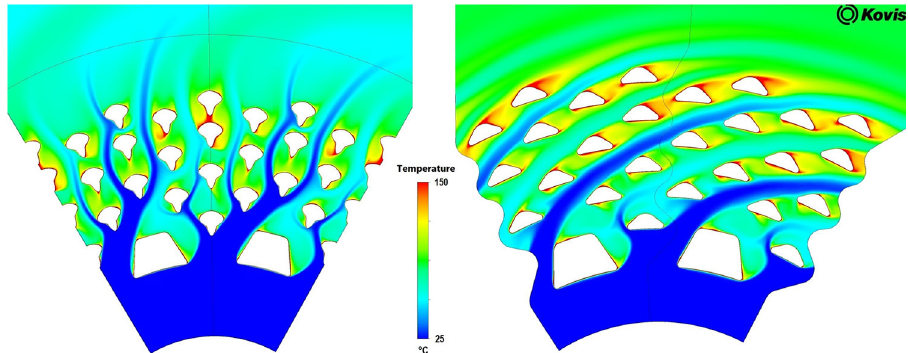
Fig. 7 Two different designs: high drag (left) and low drag (right)